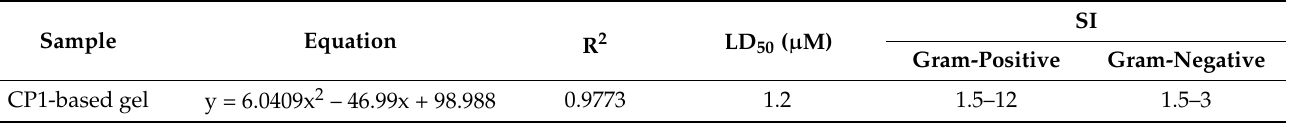
Figure 13. Curves of cells viability (%) of MAIL-2 cells exposed for 24 h to CP1-gels at concentrations of CP1 0.01–20 µM and of MAIL-2 cells not exposed to CP1-gels (CTR) ( a ); polynomial tendency line fitting the dispersion graph made with points in Figure 13a up to concentration 5 µM ( b ). Table 7. Tendency line polynomial equation, R 2 value, LD 50 of CP1, as well as the relative SI